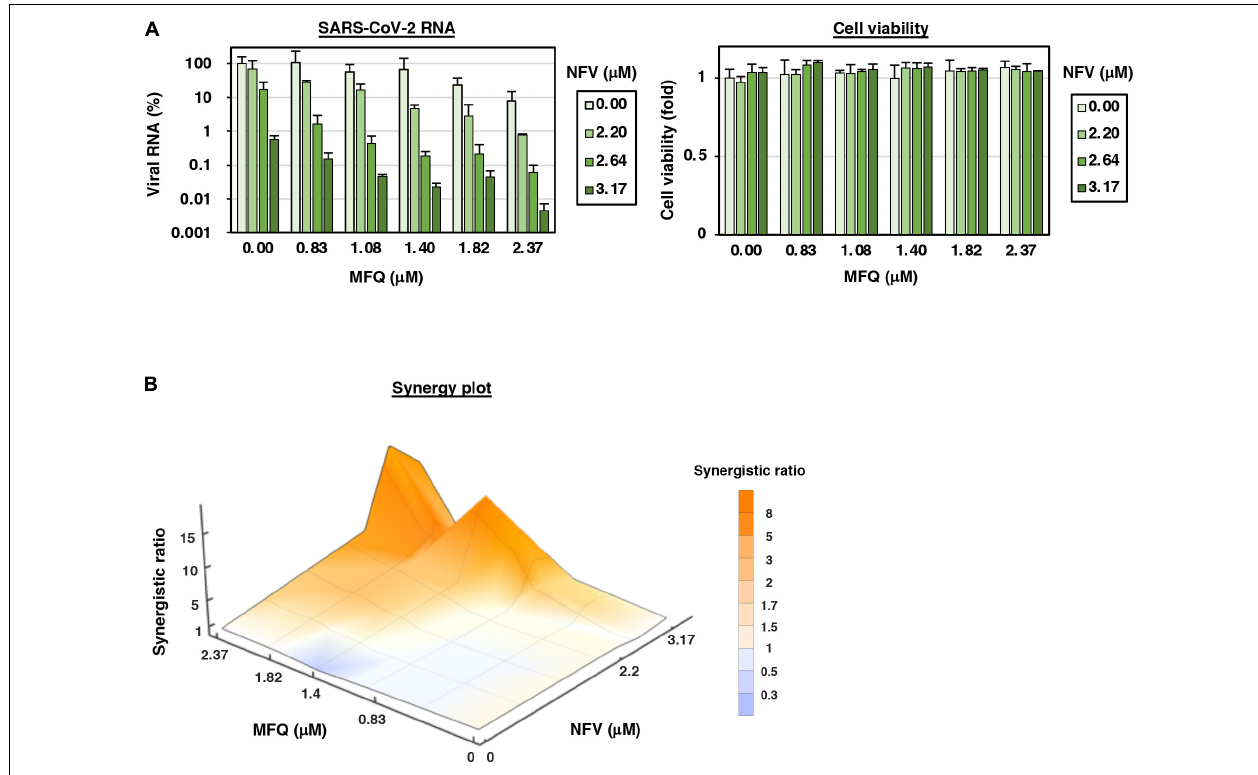
FIGURE 4 | MFQ shows synergistic anti-SARS-CoV2 activity with replication inhibitor NFV. (A) Viral RNAs in the culture supernatant at 24 h after co-treatment with MFQ and NFV were quantified by real-time RT-PCR. Relative values are shown of viral RNA or cell viability to those treated with DMSO control. Cell viability was simultaneously measured with a high content image analyzer. [MFQ at 0, 0.83, 1.08, 1.40, 1.82, and 2.37 µ M (1.3-fold-dilution); NFV at 0, 2.20, 2.64, and 3.17 µ M (1.2-fold-dilution)]. (B) The three-dimensional interaction landscapes of NFV and MFQ were evaluated with the Bliss independence model. Orange, white and dark-blue colors on the contour plot indicate synergy, additive and antagonism,